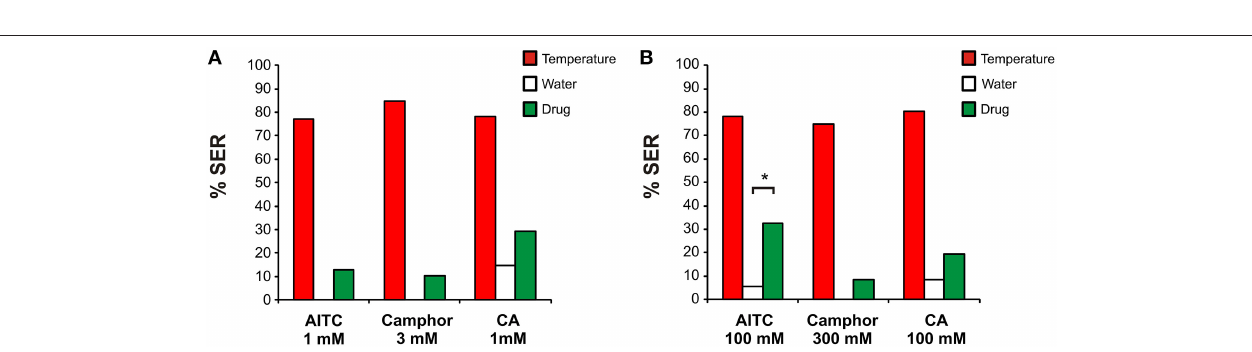
FIGURE 4 | Thermal aversive conditioning with US application on the head and the abdomen. Differential olfactory SER conditioning with a US consisting in thermal stimulation of (A) the rear of the head (vertex) or (B) the ventral abdomen (3-4 sternites). In both cases, honey bees managed to differentiate between the CS + (red dots) and the CS − (white dots) along the 8 trials ( *** p < 0.001 ).